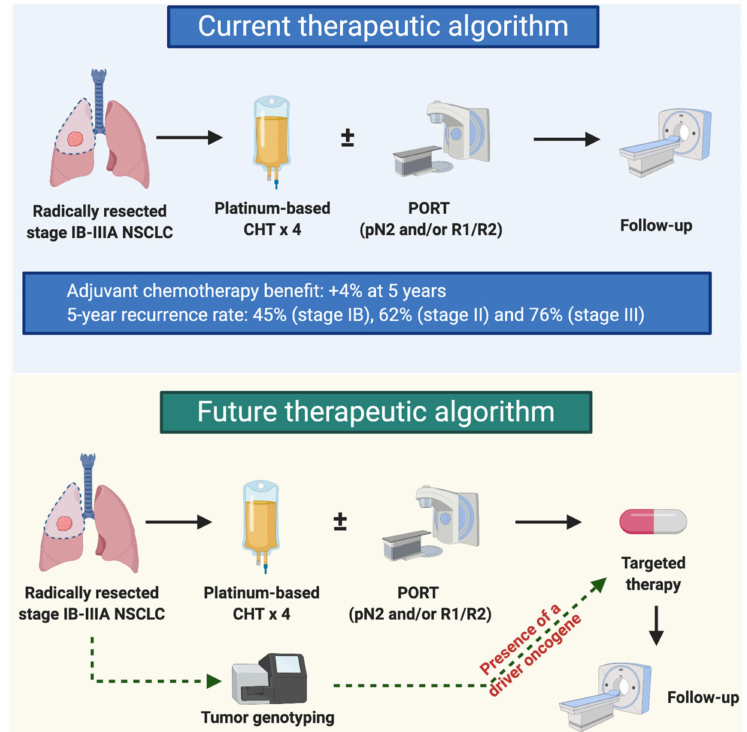
Figure 1. Potential role of targeted therapies in the adjuvant setting. Post-operative platinum-based chemotherapy (CHT) in stage IB-IIIA resected non-small-cell lung cancer (NSCLC) has been associated with a 4% survival benefit at 5 years [7]. According to the Lung Adjuvant Cisplatin Evaluation (LACE) study, 5-year recurrence rates range from 45% in stage IB to 76% in stage III after adjuvant chemotherapy [8]. Post-operative radiotherapy (PORT) is currently recommended in patients with pathologic N2 (pN2) disease and in those with microscopic (R1) or macroscopic (R2) residual